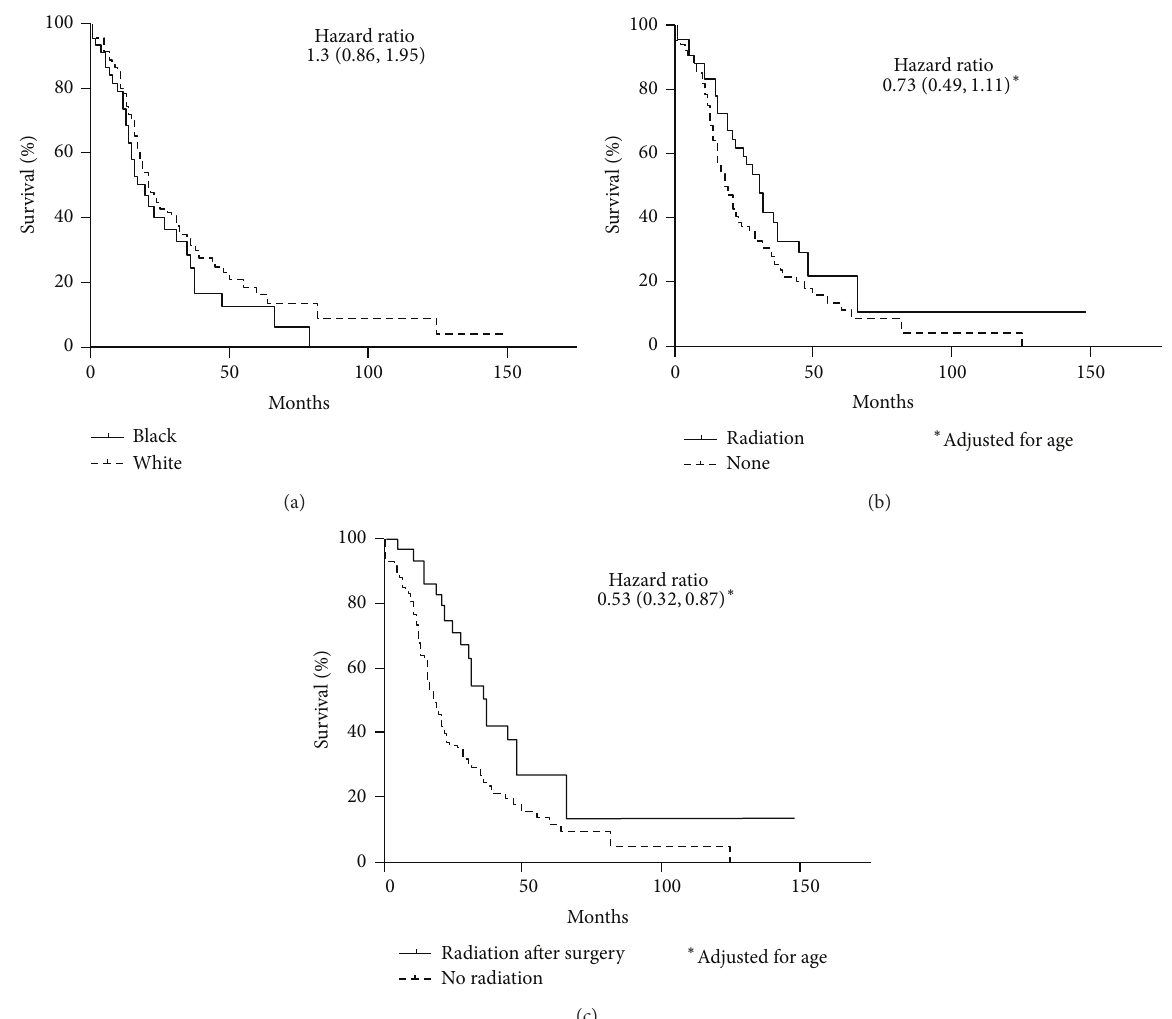
Figure 2: (a) Race-based survival of DSRCT. There may be a survival disadvantage for blacks compared to whites. Although it did not reach statistical significance, this analysis suggests that blacks are 33% more likely to succumb to DSRCT than are whites ( 𝑃 = 0.2 ). (b) Treatment- based survival of DSRCT, radiation versus no radiation. There was no statistically significant difference in survival amongst patients who receivedradiationtherapycomparedtothosewhodidnot.(c)Treatment-basedsurvivalofDSRCT,radiationaftersurgeryversusnoradiation. Patients who received radiation following surgery fared better than those patients who did not ( 𝑃 < 0.05 ).